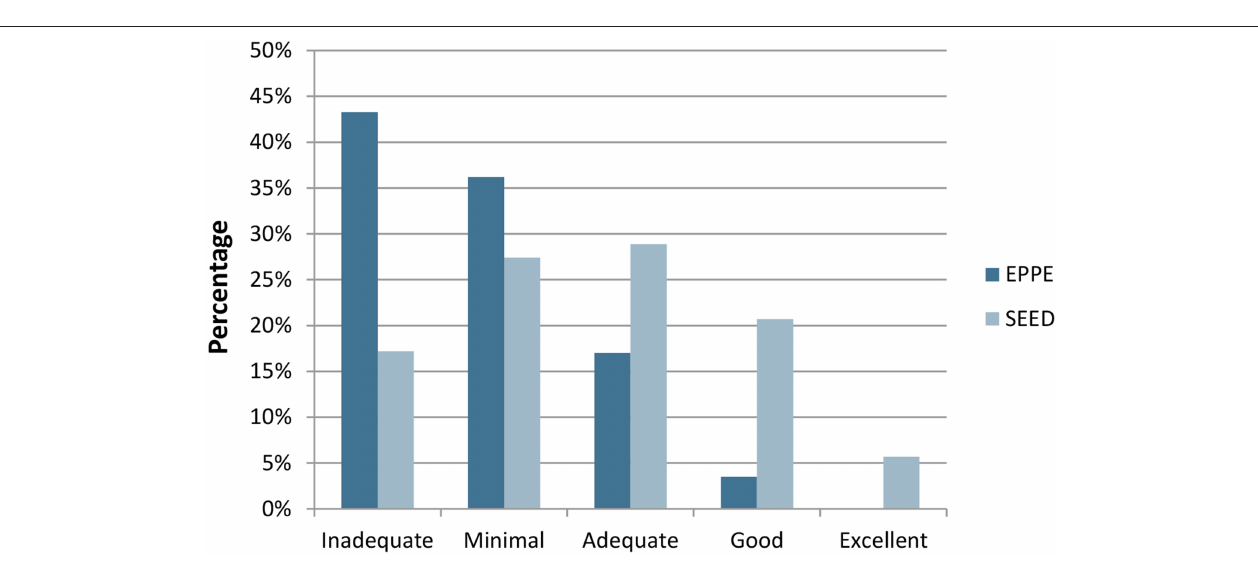
FIGURE 2 | Percentage breakdown of ECERS-E scores by quality level in the EPPE and SEED studies. Quality is classified as Inadequate ( < 3), minimal ( ≥ 3 and < 4), adequate ( ≥ 4 and < 5), good ( ≥ 5 and < 6) or excellent ( ≥ 6). Figure © 2017 NatCen Social Research, University of Oxford and Action for Children, reproduced with